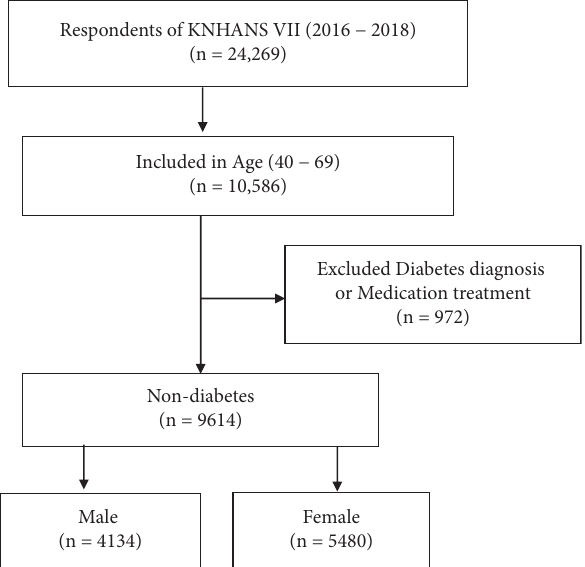
Figure 1: Flowchart of the inclusion of the study